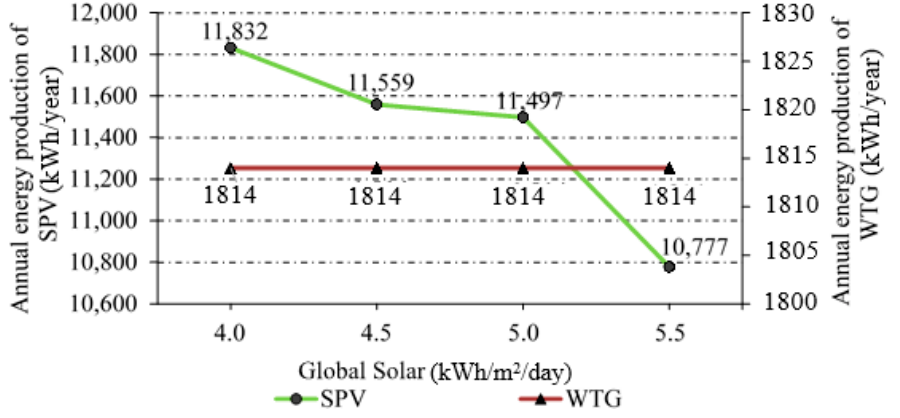
Figure 13. Annual energy contribution of different sources with different average solar radiation values and 4.0 m/s wind speed.